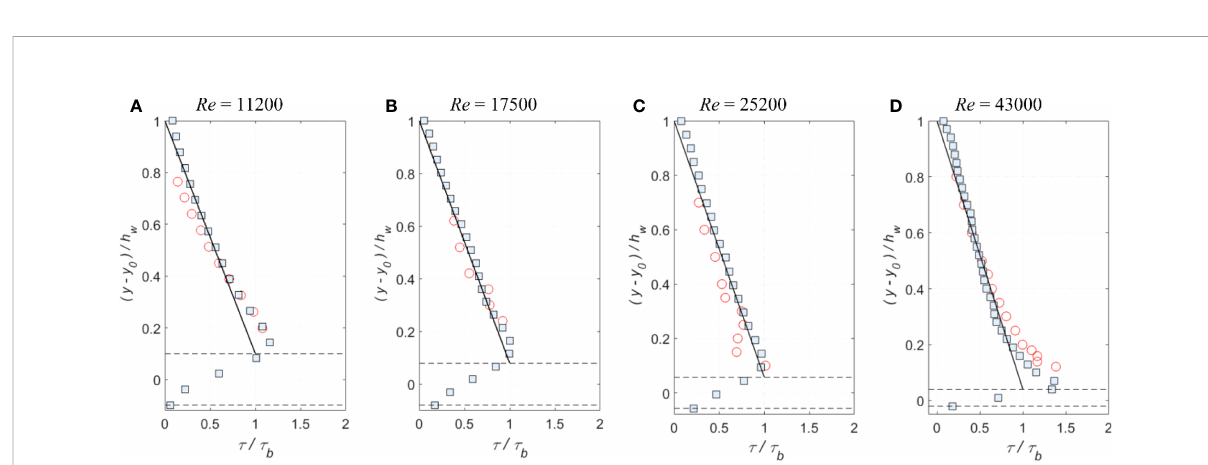
FIGURE 6 (A – D) Comparisons of time-averaged shear stress pro fi les at the fl ume centerline for different fl ow conditions (circles: exp data; squares: smoothed particle hydrodynamics [SPH]; solid black lines: analytical; and dash lines: roughness top and